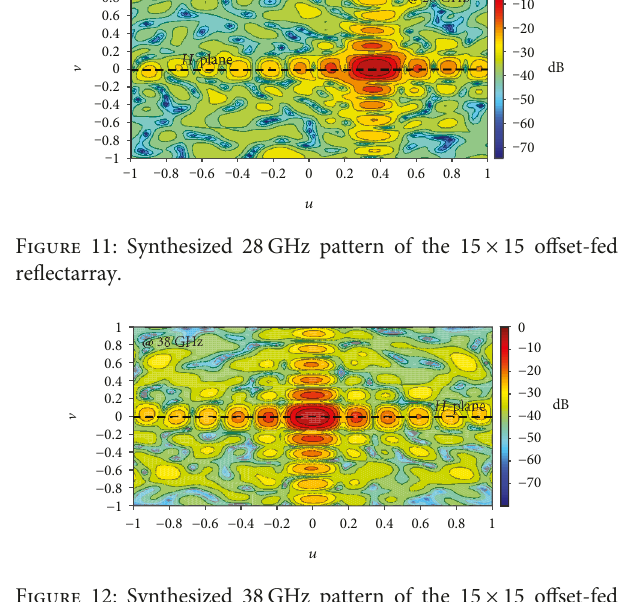
Figure 12: Synthesized 38 GHz pattern of the 15 × 15 o ff set-fed re fl